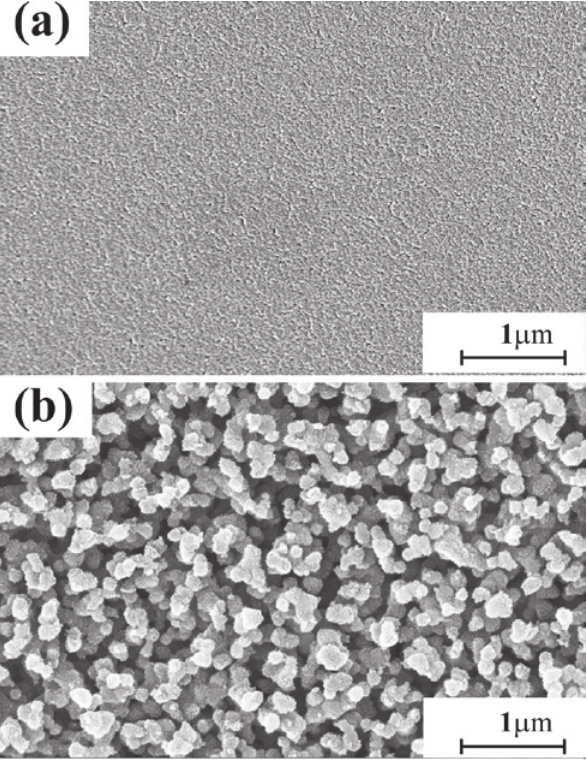
Fig. 9: SEM micrographs of ceramics annealed at 1800 °C: (a) SiCB-3 and (b) SiC.